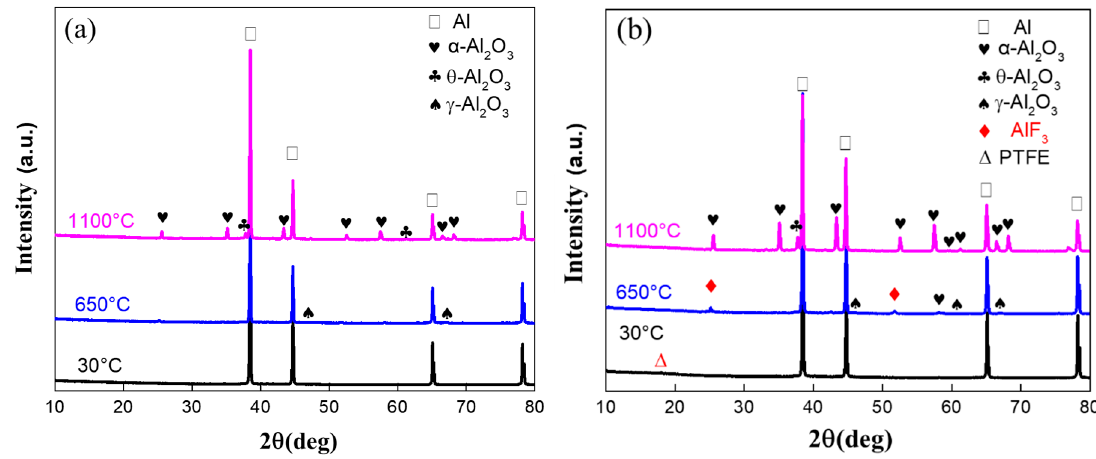
Figure 9. SEM graphs of recovered Al ( a , c , e , g ) and Al/PTFE ( b , d , f , h ) powders at different temperatures. ( a , b ) 550 °C; ( c , d ) 650 °C; ( e , f ) 960 °C; ( g , h ) 1100 °C. The samples were recovered from TGA analysis.